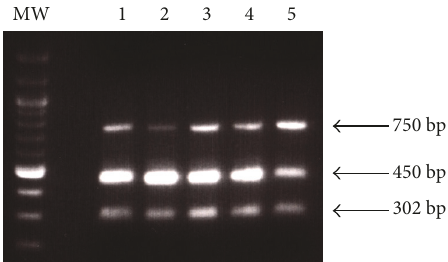
Figure 3: Determination of the fimS invertible element orientation in strain NU149 mixed with plain Sepharose beads or mannose- coated Sepharose beads in pH 5.5 or pH 7.0 media by PCR analysis. The PCR analysis was performed with chromosomal DNA isolated from the NU149 cells using the INV and FIMA primers to amplify Phase-ON-oriented DNA (450bp product), FIME and INV primers to amplify Phase-OFF-oriented DNA (750 bp product), and EcFtsZ1 and EcFtsZ2 primers to amplify the ftsZ gene (302 bp product). The products were standardized against the ftsZ product using ImageQuant software and the corrected values for both orientations were standardized to the respective 0 h time point. The lanes were loaded as follows: MW = molecular weight standard; lane 1, NU149 at time 0h; lane 2, NU149 time 24 h, mannose-coated at pH 7.0; lane 3, NU149 time 24 h, plain at 24 h; lane 4, NU149 time 24 h, mannose- coated at pH 5.5; lane 5, NU149 time 24 h, plain at pH 5.5. All PCR products were electrophoresed on 1.5% agarose